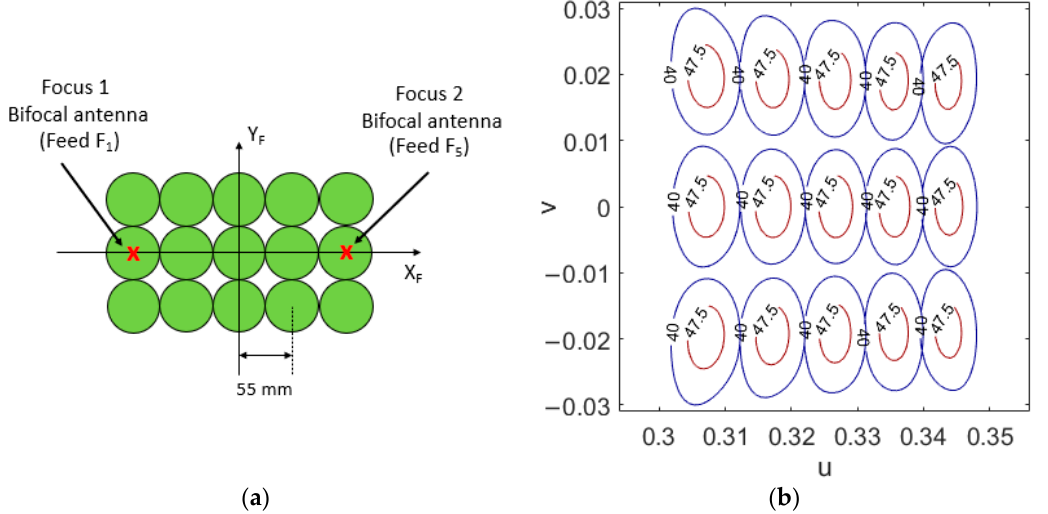
Figure 9. ( a ) Cluster of horns used to illuminate the antenna, including the location of the foci, ( b ) pattern contours of 40 dBi and 47.5 dBi for the beams produced by the bifocal DRAA at 20 GHz.